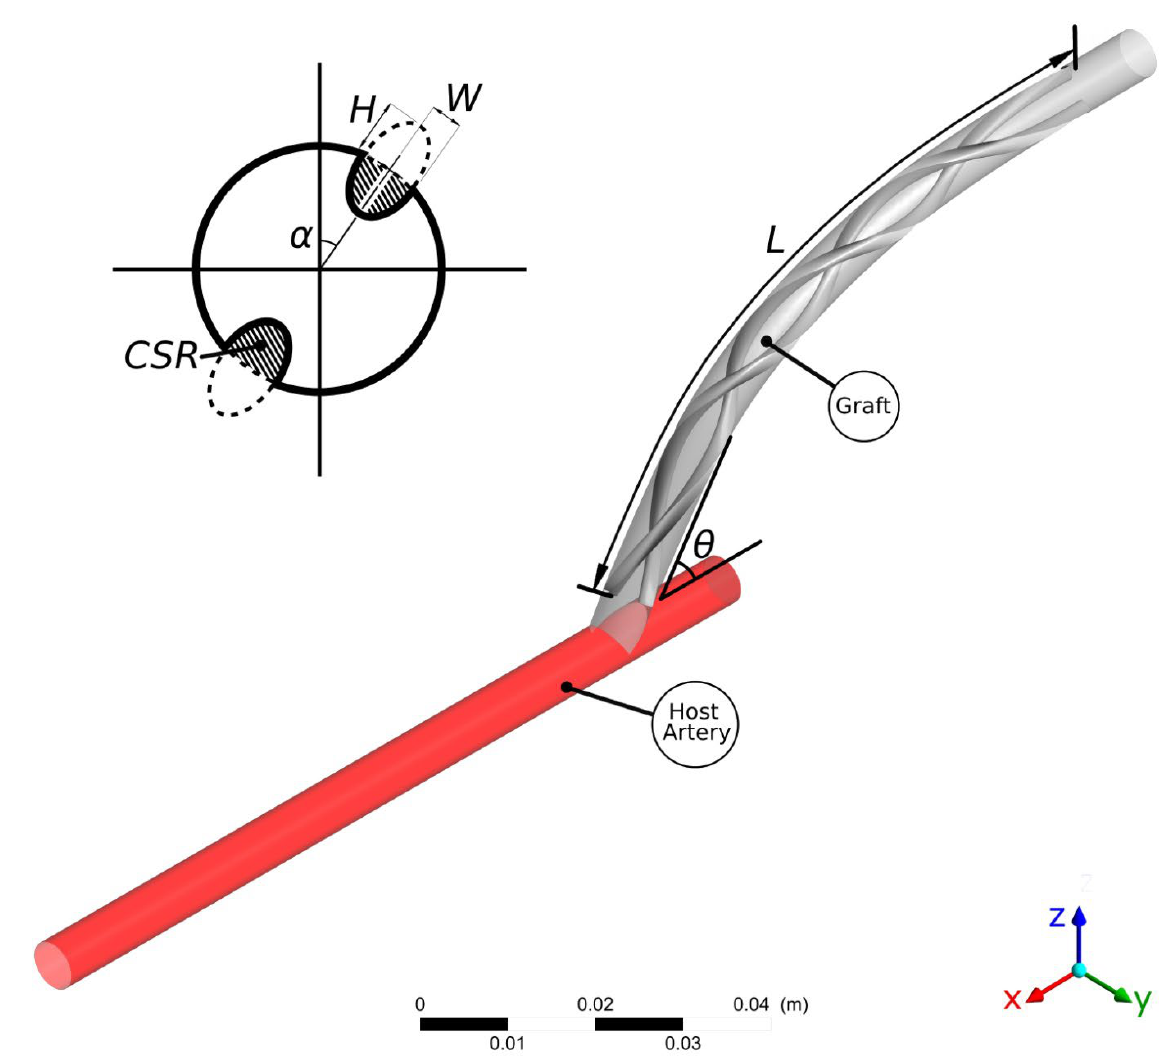
Figure 1. Computational configuration of the graft and host artery for the multi-objective optimisation study, here presented for a case with two ridges: CSR is the occlusion area; H and W are the ridges’ height and width; α is the trailing edge orientation; θ is the anastomosis angle; and L is the ridge length.